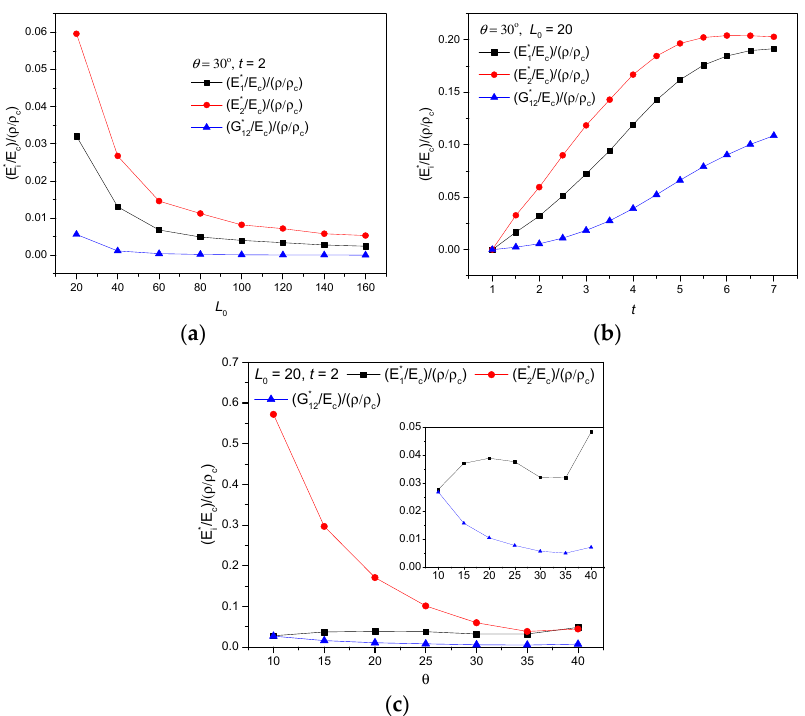
have a resembling variation of first decline and then ascent, while down-up variation. In the range of =35 θ  to =40 θ increase monotonically.